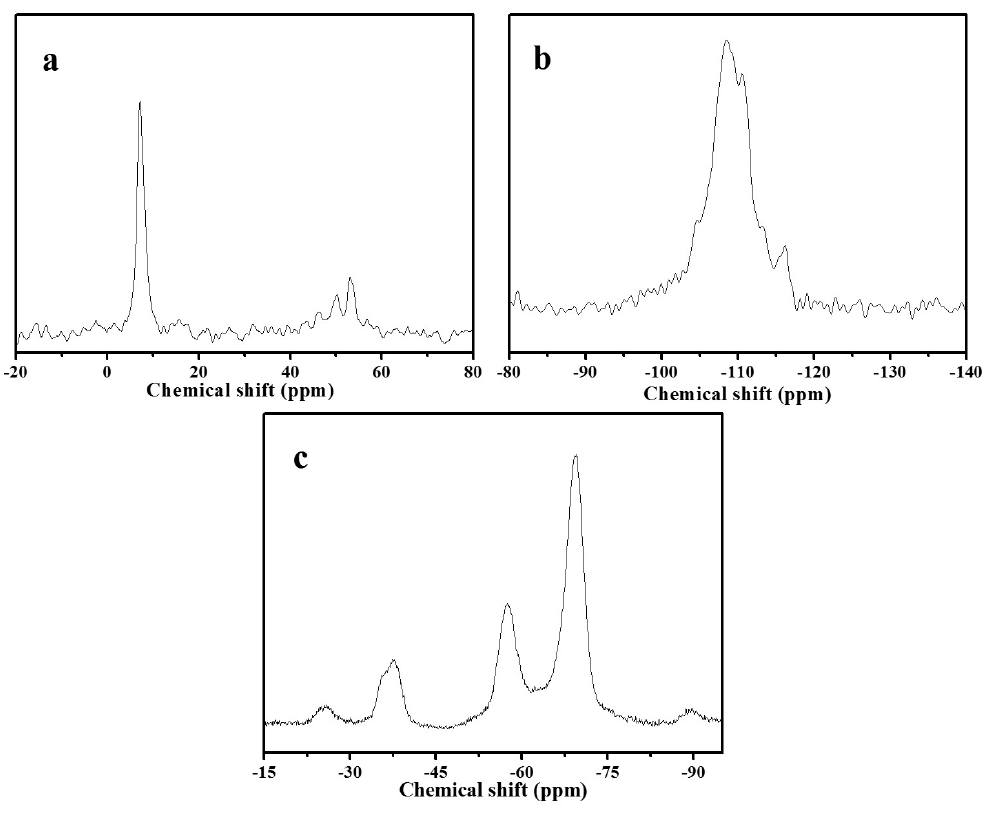
Figure 5. ( a ) 13 C; ( b ) 29 Si and ( c ) 19 F MAS NMR spectra of as-synthesized S-Beta sample after water